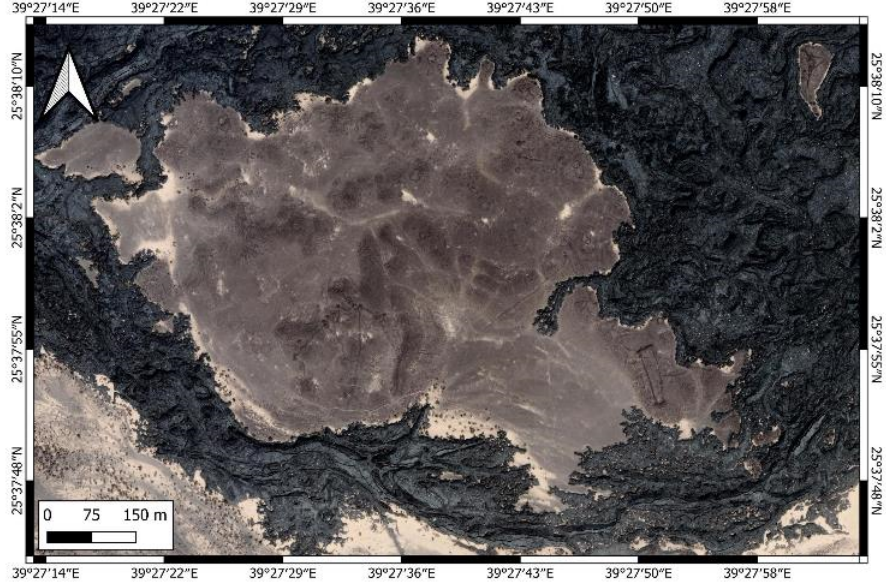
Figure 16. Smooth-surfaced old surface surrounded by rugged fresh lava flows locking desert kites in that are unlikely places to erect, as the enclosed areas are unlikely regions for free game migration as they are blocked by the lava